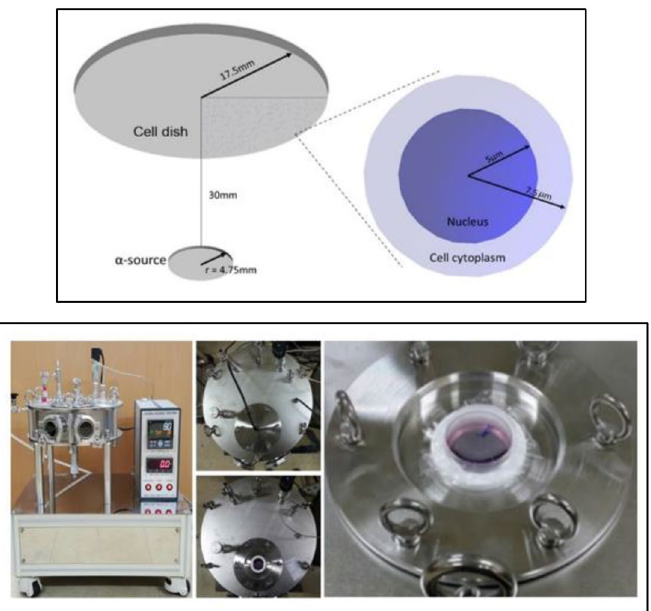
Figure 1. A geometrical model (left) for simulating cell exposure to alpha particles performed using the alpha particle irradiator (right) in the Radiation Bioengineering Laboratory at Seoul National University 18 : The bottom of Mylar cell dish, with cells on the top is placed in parallel over an alpha-emitting disc